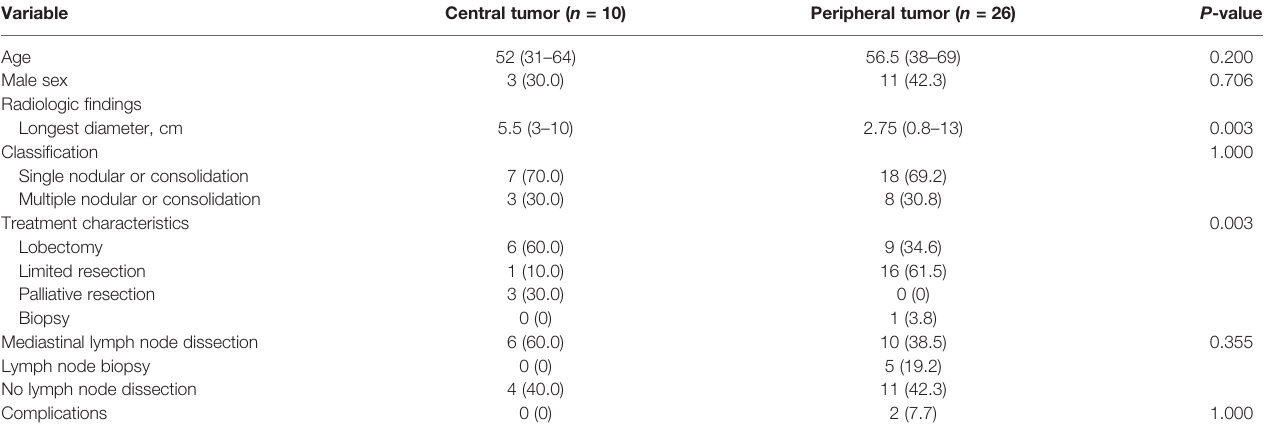
TABLE 2 | Clinical characteristics and treatment options in patients with central tumors and peripheral tumors. Variable